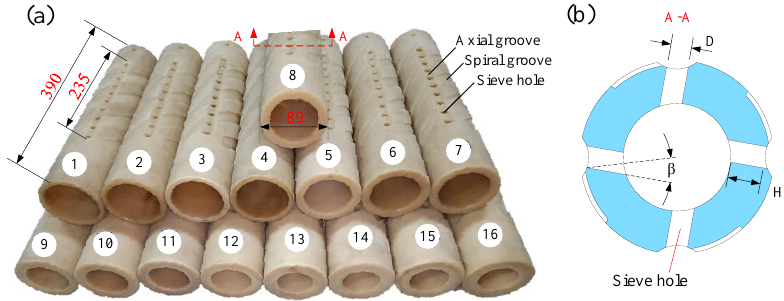
Table 2. Factors and levels in orthogonal test.